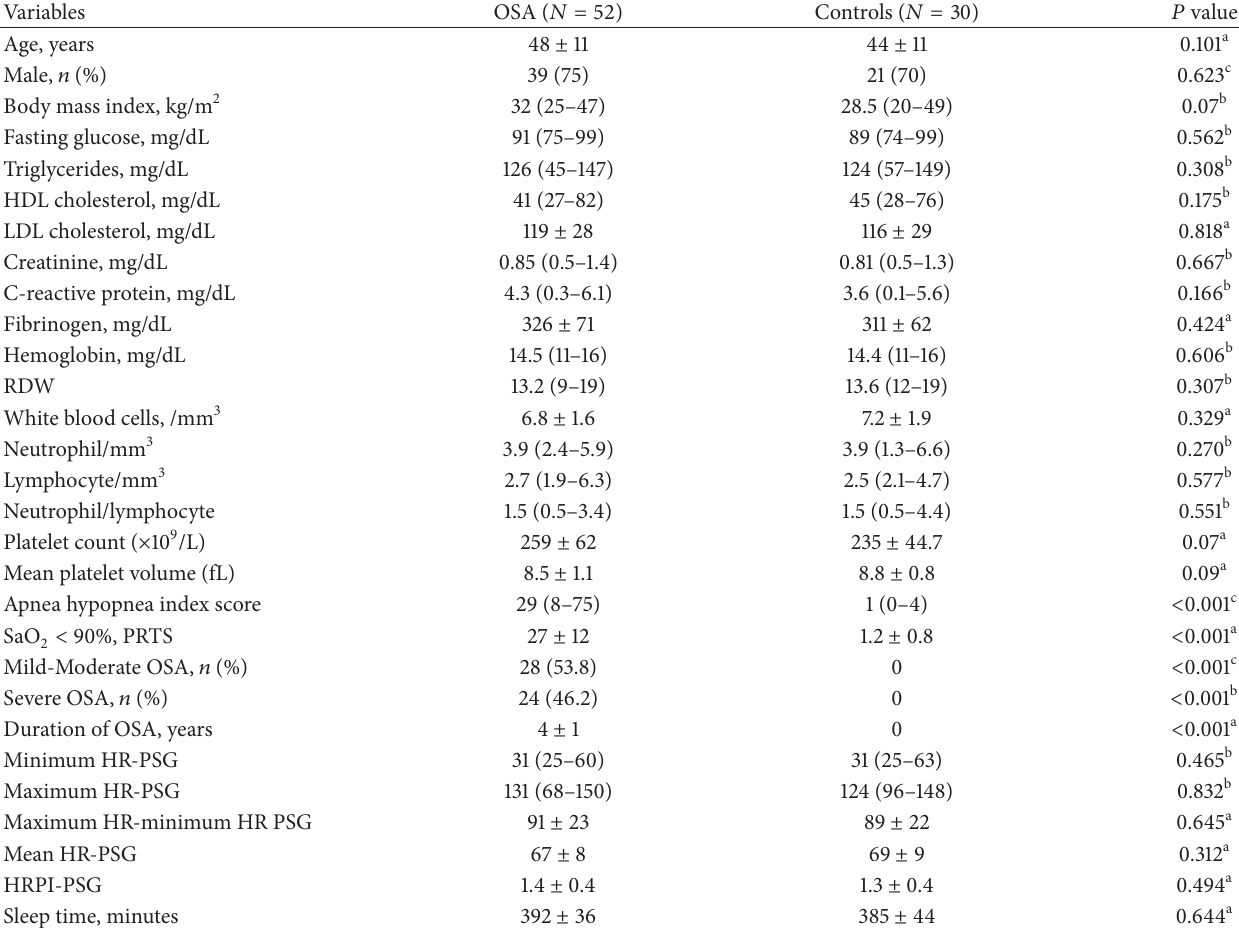
Table 1: Anthropometric, clinical features, and biochemical variables of the two